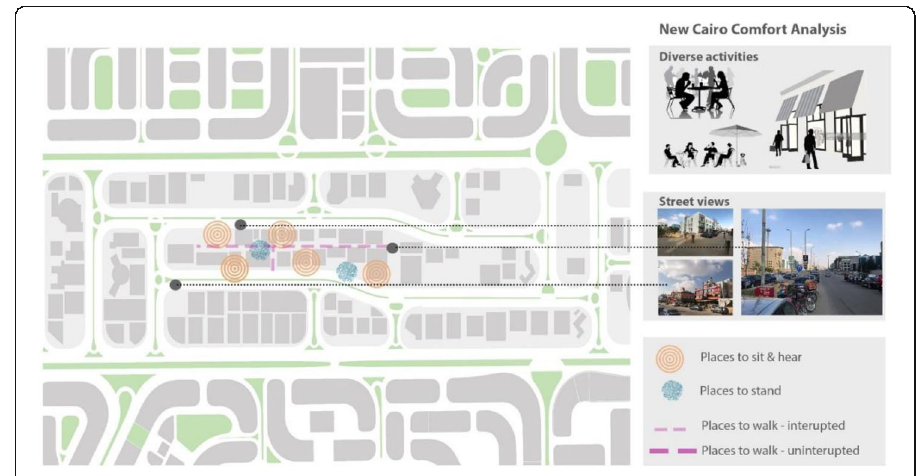
Fig. 12 New Cairo map, analysis of comfort aspect in the Banks Street zone (Author)